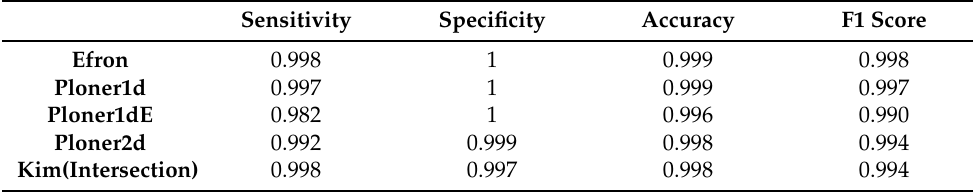
Table 2. Basic scenario (two-sided alternative): Performance measures when cutoff =